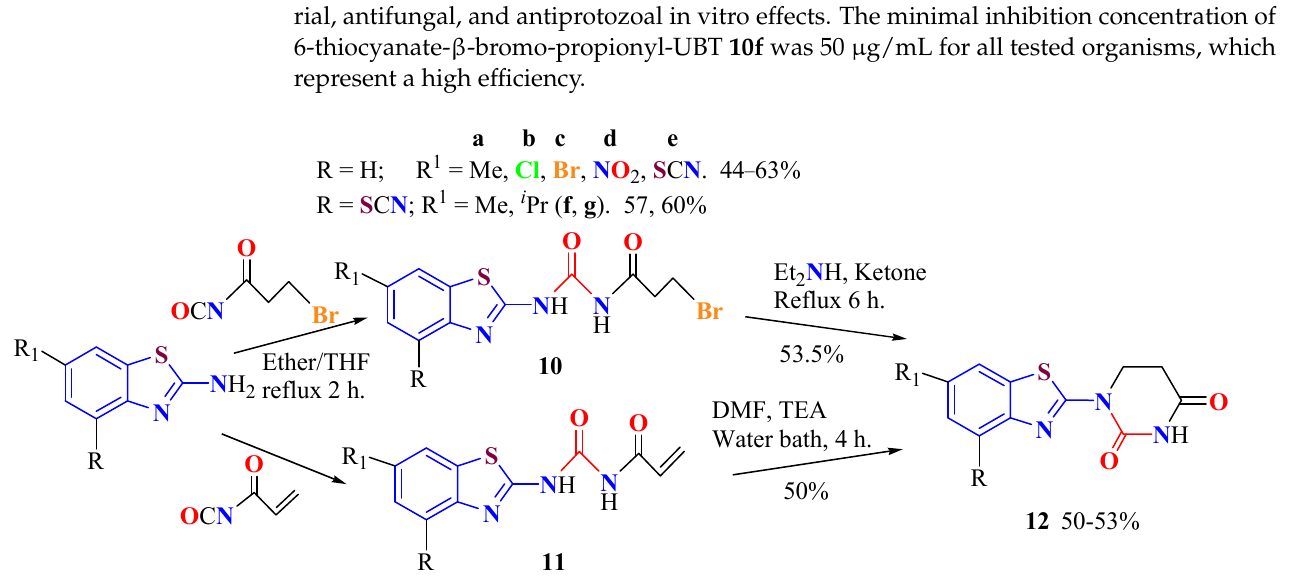
Scheme 3. 4,6-disubstituted- β -bromo-propionyl-UBTs 10 and 4,6-disubstituted-ethenoyl-UBTs 11 to produce dihydrouracils 12